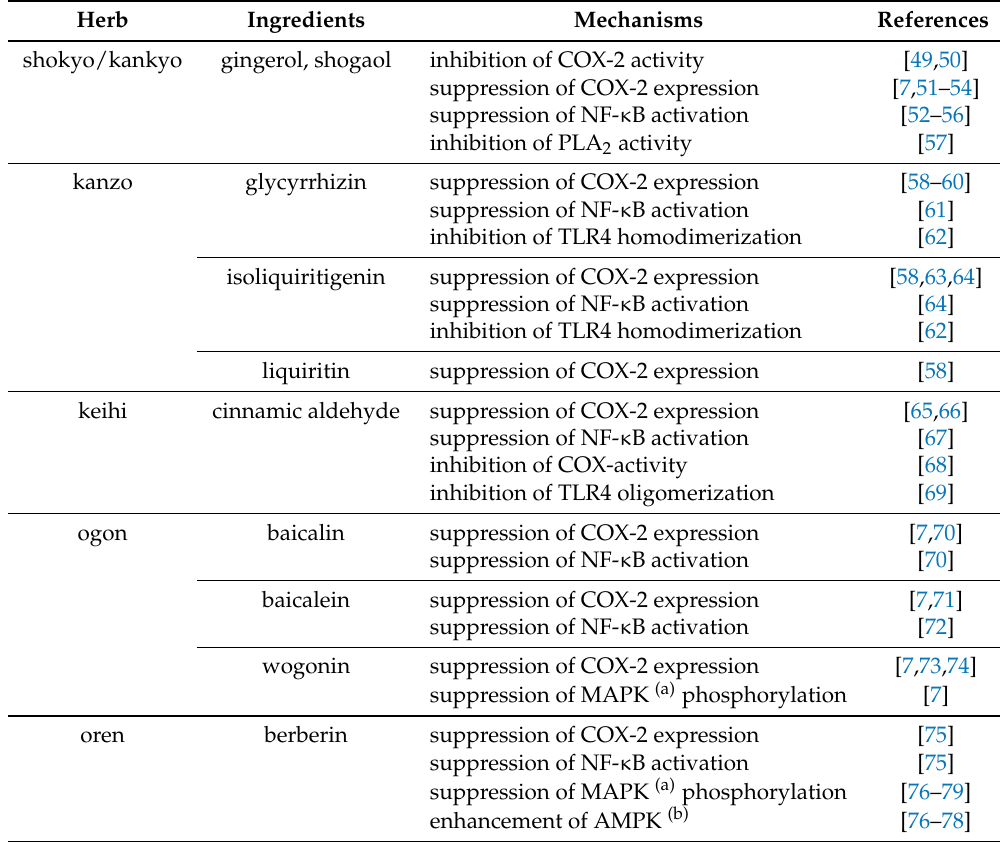
Table 8. Major ingredients in herbs and their mechanism against arachidonic acid